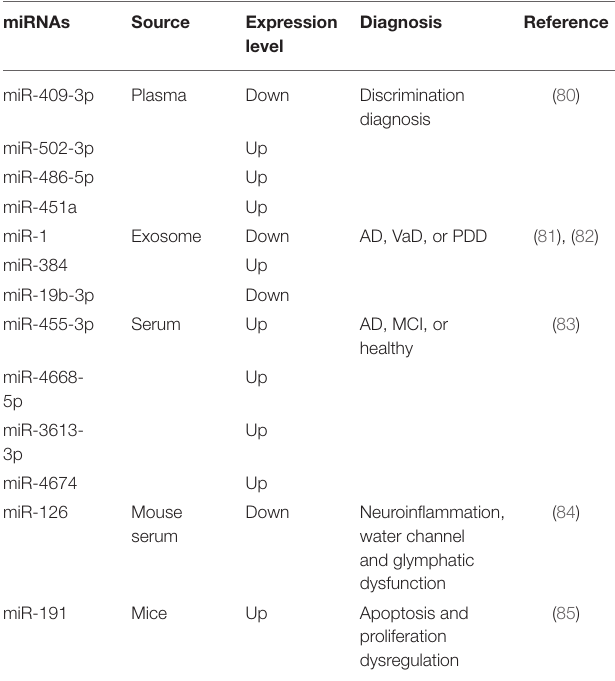
TABLE 1 | Changes in miRNAs expression level and its role in disease diagnostics.